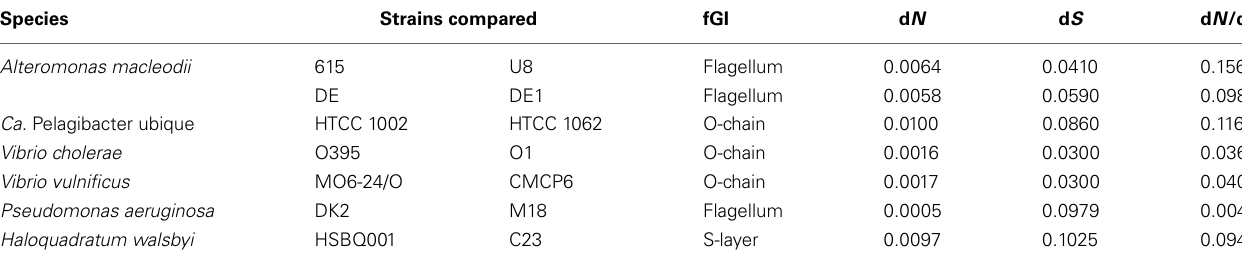
Table 2 | d N and d S values for the genes in the 10Kb adjacent to both sides of the fGI. Species Strains compared fGI d N d S d N /d S Alteromonas macleodii 615 U8 DE1